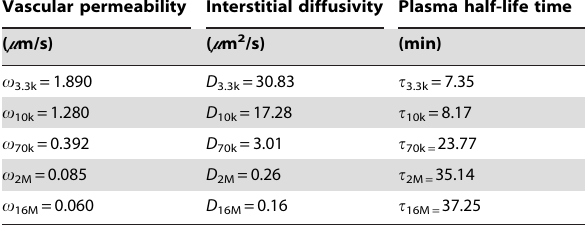
Table 1. The characteristics for dextrans of different molecular